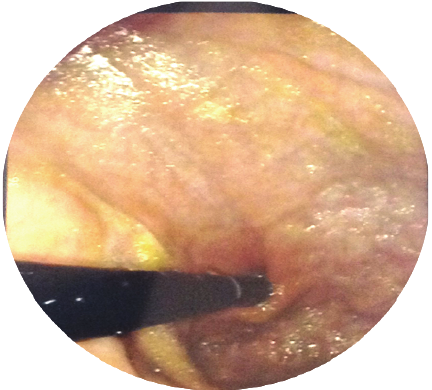
Figure 2: Atrophic gastritis of the fundus.